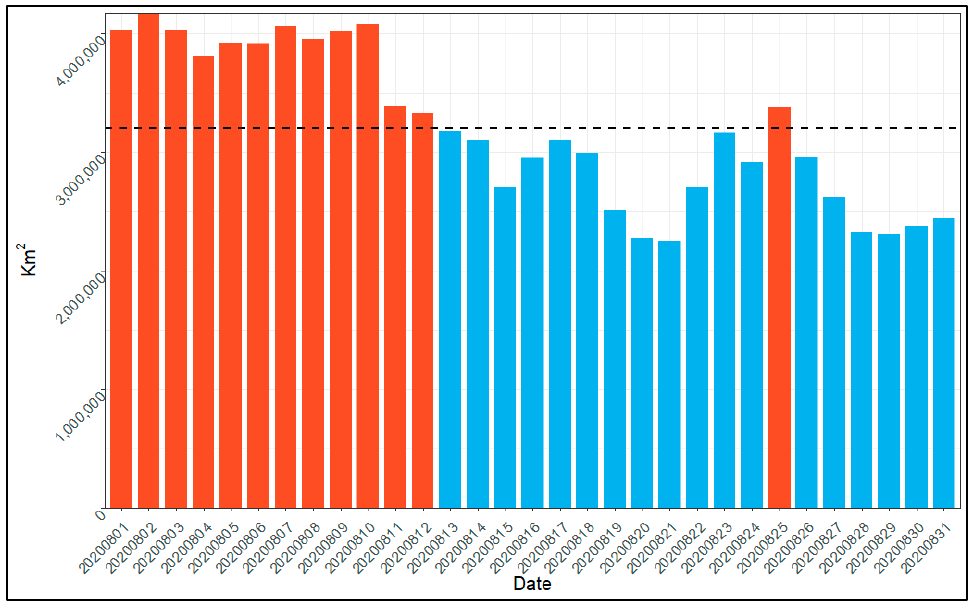
Figure 8. Area statistics of daily heat stress area. The red columns indicate that the area of heat stress exceeds 33% of the country's land area, while the blue columns indicate that it does not.